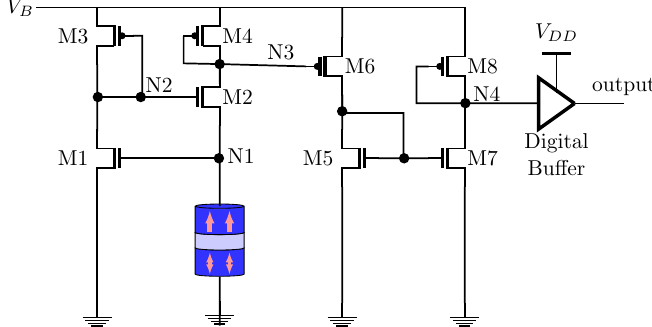
Figure 16. The MTJ-based voltage-controlled stochastic oscillator (VCSO) proposed in Reference